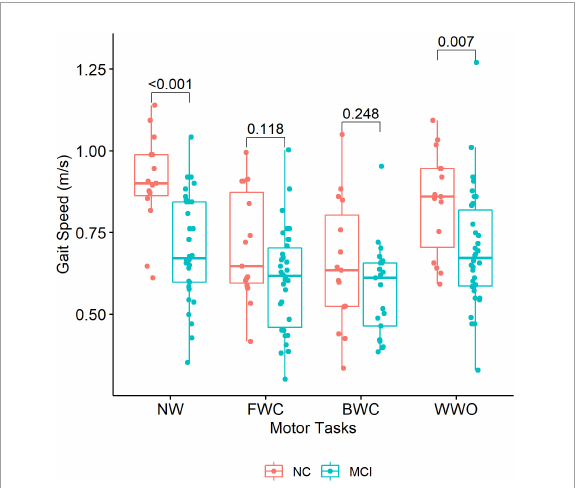
FIGURE4 Gait speed across the dual-task paradigm during CBF monitoring. The boxplots depict gait speed during each task stratified by group (NC vs. MCI). P -values of between-group differences are indicated with brackets above the boxplots. NW, normal walk; FWC, walk while 2-forward count; BWC, walk while 3-backward count; WWO, walk while negotiating obstacles; NC, participants with normal cognition; MCI, mild cognitive